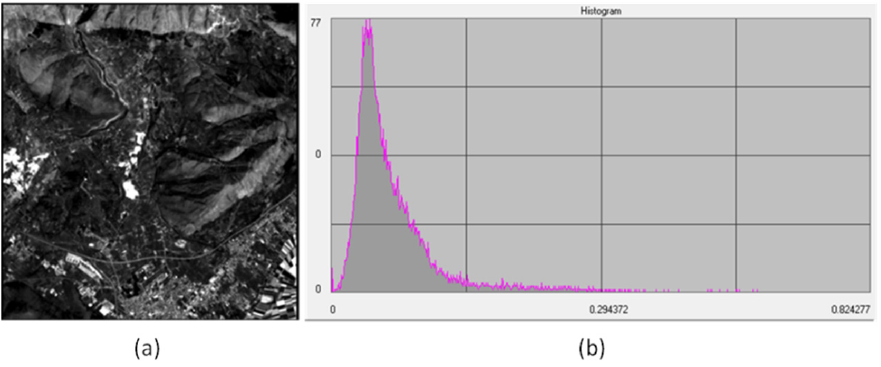
Figure 4. Alba Fucens “good band n. 24”: ( a ) VNIR image; and ( b ) histogram. In band 2 of VNIR cube, classified as a bad band, the “salt and pepper” effect of the red points shows the lack of data in most of the image (Figure 5a); the relative histogram presents an irregular shape (Figure